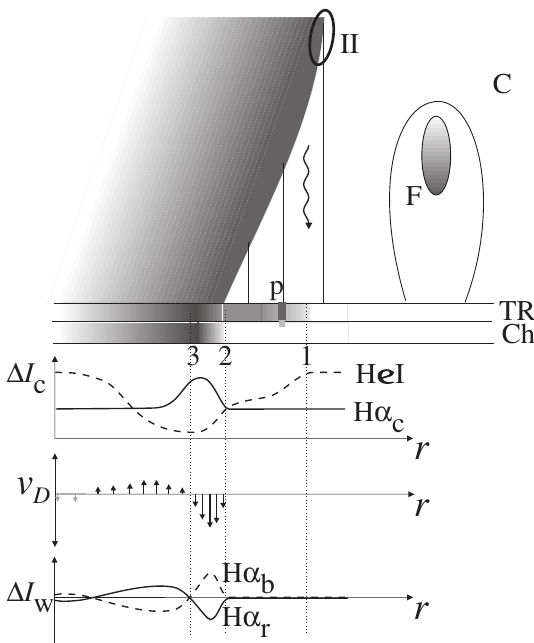
Figure 42: Schematic presentation of the passage of a tilted fast-mode MHD shock through the corona ( C ) and its signatures in the transition region ( TR ) and chromosphere ( Ch ). The curves below the main graph show idealized intensity profiles of the waves seen in H α line center and He i (upper plot), the Doppler velocity profile (middle) and the profiles in the wings of H α (lowermost plot). The H α and Doppler signatures, as well as the main He i perturbation are generated by the impact of the coronal shock on the chromosphere. A more shallow signature in He i is generated in front of the main perturbation by increased irradiation, heat flux, and possibly accelerated particles from the higher parts of the inclined shock front. At the quasi-perpendicular part of the shock, a type II burst is generated. Note that the higher parts of the shock will reach a filament ( F ) before the disturbance in the lower atmosphere. Image reproduced with permission from Warmuth et al. (2004b), copyright by